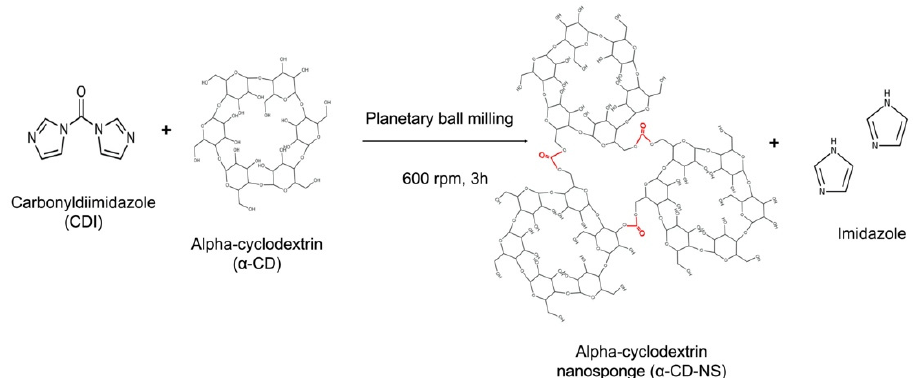
Figure 1. Cross-linking reaction of carbonyldiimidazole and α -cyclodextrin using ball milling, generating α -cyclodextrin nanosponges and free imidazole.